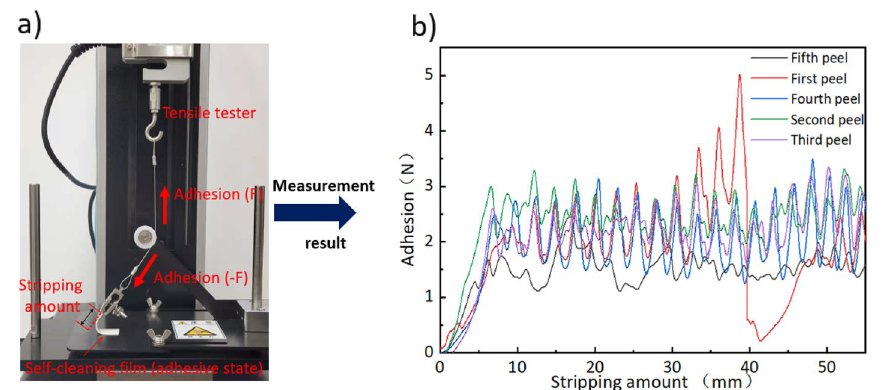
Figure 8. ( a ) Self-cleaning film adhesion and strength measurement method. ( b ) Film adhesion measurement results after five times of adhesion and